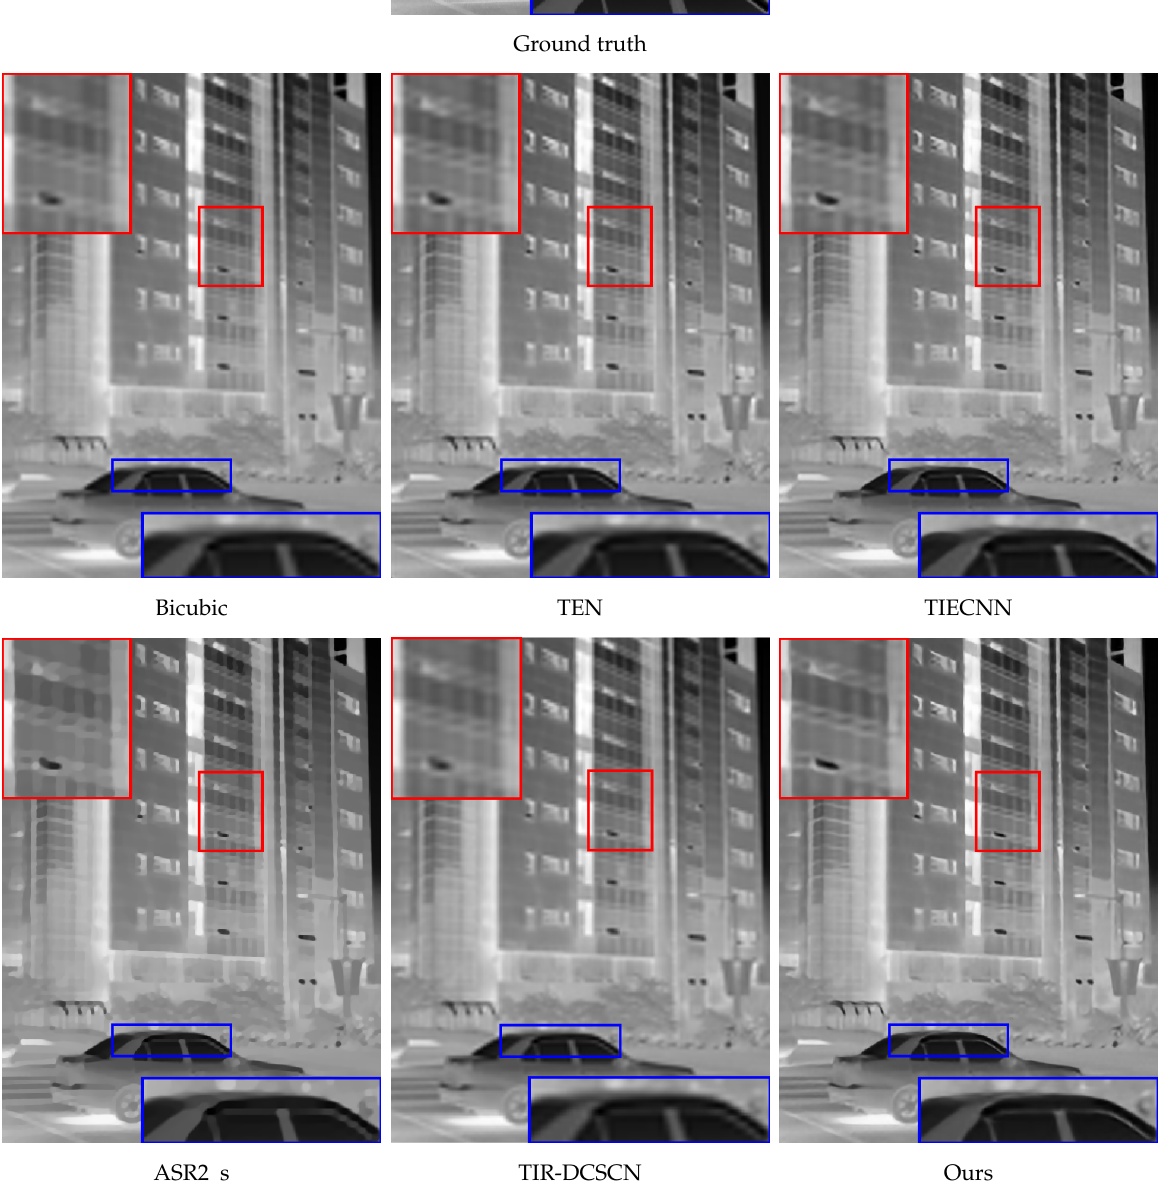
Figure 12. Qualitative comparison on the test dataset